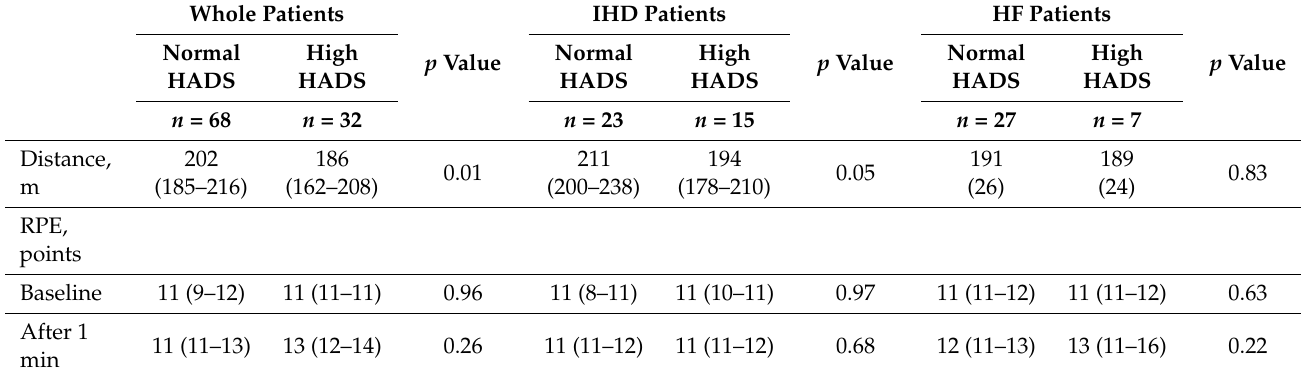
Table 4. The differences of 2 min walking test between normal HADS group and high HADS group in whole patients, IHD patients, and HF